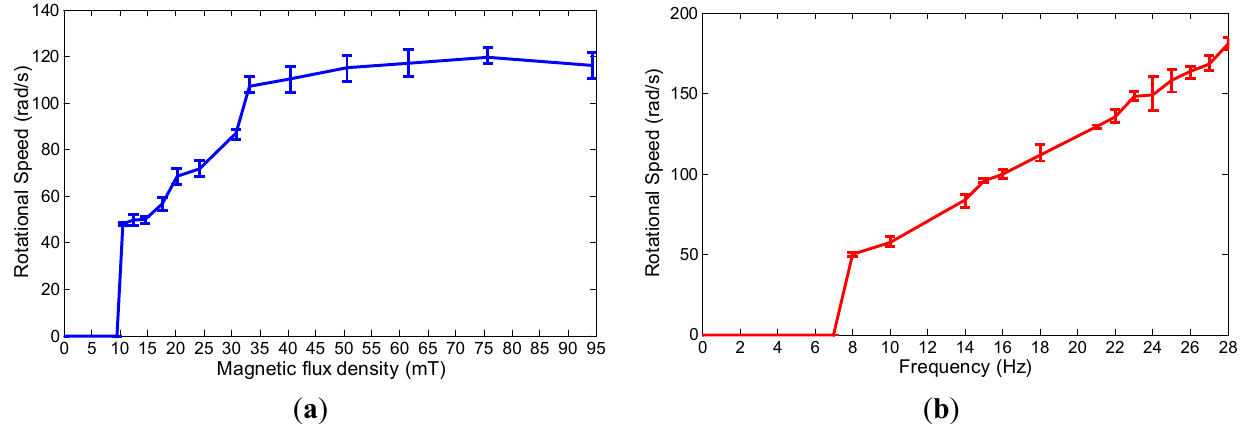
Figure 11. Measurement results of the rotational speed of the magnetic actuated microrobot. ( a ) Rotational speed of the electromagnet actuated microrobot; ( b ) Rotational speed of the permanent magnet actuated microrobot.